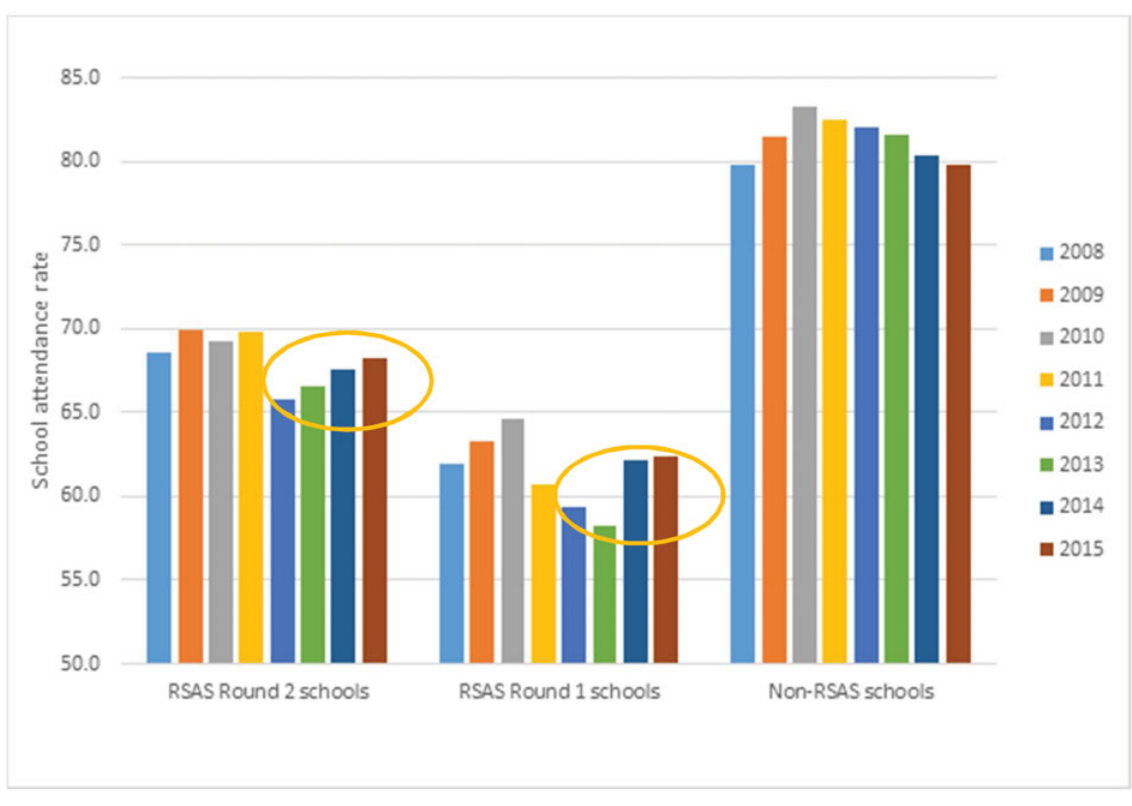
(Colour online) Attendance rates from 2008 to 2015 for very remote schools nationally. Data are grouped according to round 1, round 2, and nonRSAS very remote schools.Source: A Red Dirt Journey (Guenther, Osborne and Disbray,